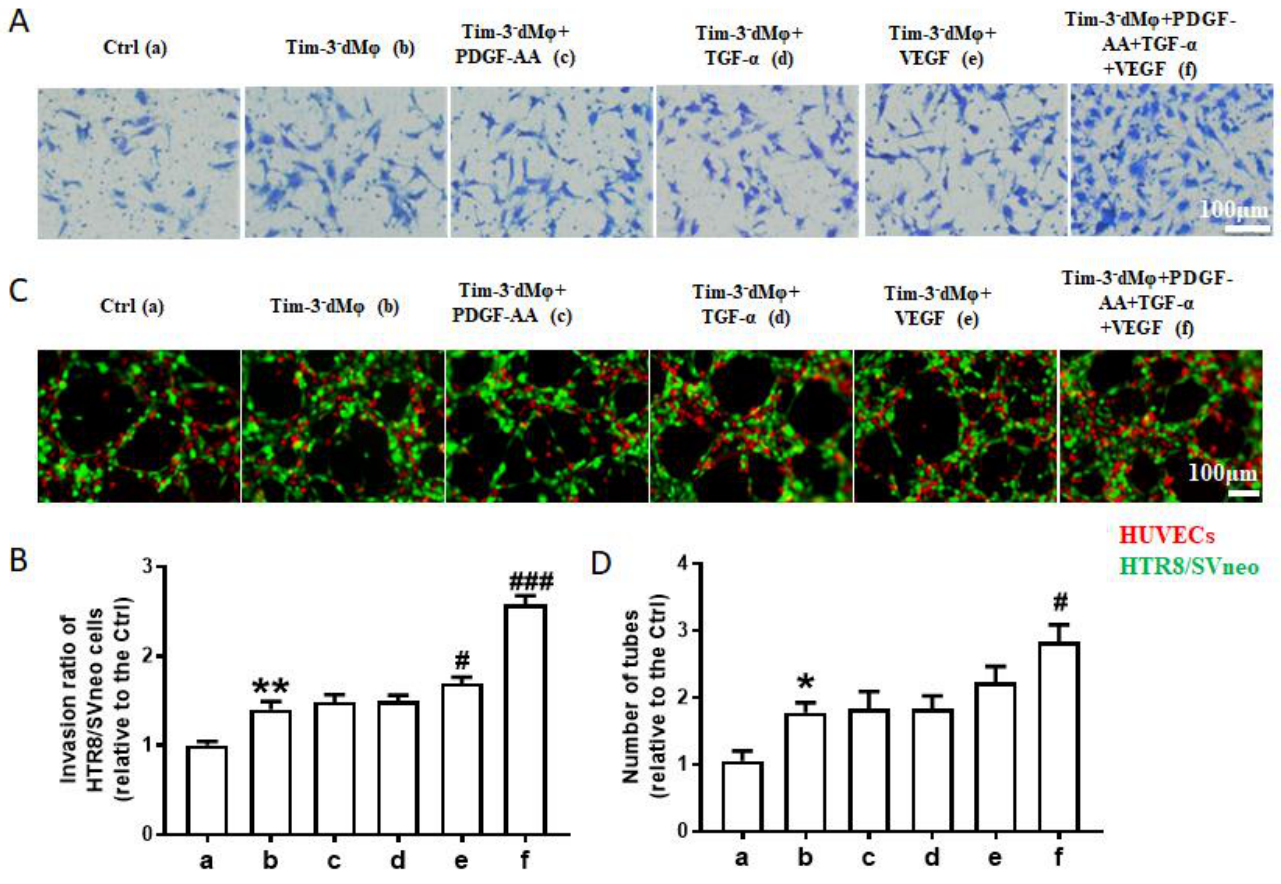
Figure 5. AGFs-treated Tim-3 - Mφs enhanced the invasion and tube formation ability of trophoblasts . ( A , B ) Matrigel invasion assays of HTR8/SVneo cells treated with indicated Tim-3 - dMφs (pretreated with or without PDGF-AA, and/or TGF- α , and/or VEGF). ( C , D ) Immunofluorescent assay at 4 h of the 3D tube formation by HTR8/SVneo cells (green) and HUVECs (red) with indicated treatment. Data represent the mean ± SEM. * p < 0.05, ** p < 0.01, compared with the group a. # p < 0.05, ### p < 0.001, compared with group b. a: Ctrl, b: Tim-3 - dMφs , c: Tim-3 - dMφs +PDGF-AA, d: Tim-3 - dMφs +TGF- α , e: Tim-3 - dMφs +VEGF, f: Tim-3 - dMφs +PDGF-AA+TGF- α +VEGF.